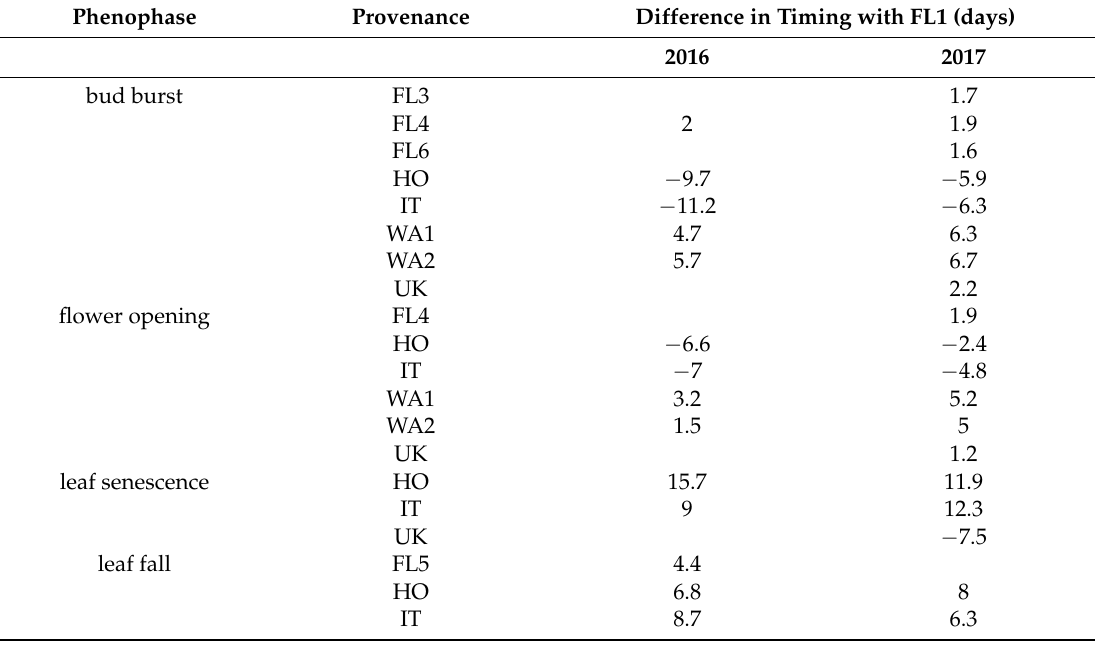
Table 4. Differences in timing between the standard local provenance FL1 and the other provenances in the common garden in 2016 and 2017 for the four phenophases. Time spans are shown only for the provenances that differed significantly from the standard provenance FL1 in the models (Table 3, Table S1). Negative values indicate earlier timing of the phenophase, positive values indicate later timing. Provenance abbreviations are given in Table